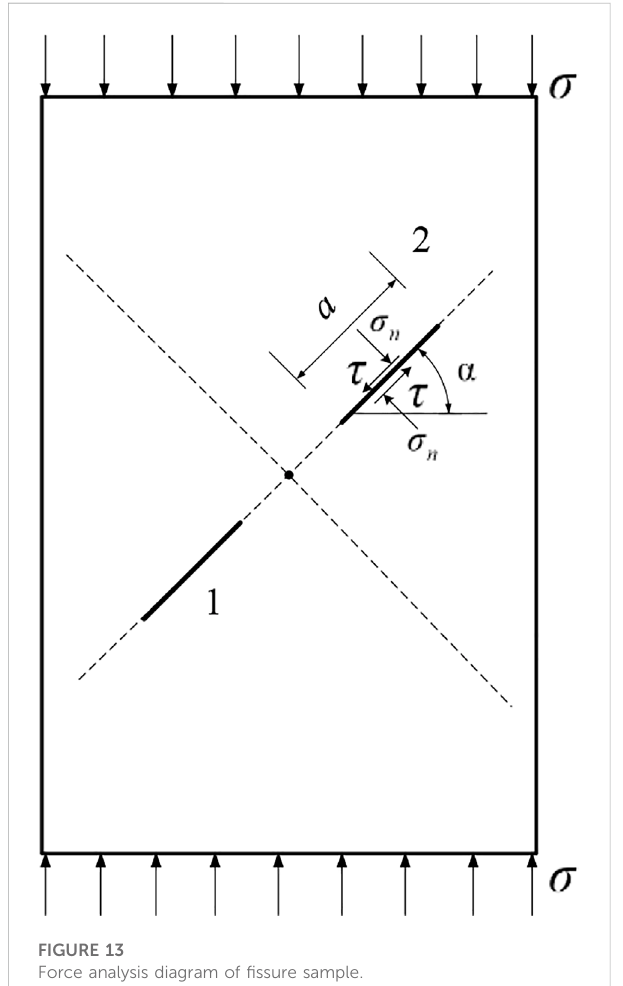
FIGURE 13 Force analysis diagram of fi ssure sample.